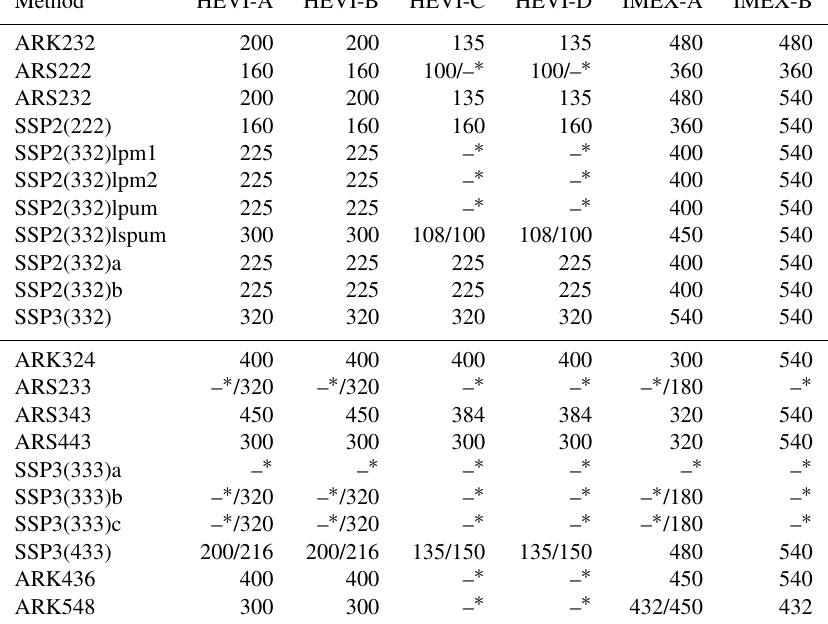
Table 1. Approximate largest stable step size (in seconds) for a 30-day run of the baroclinic wave test. Second-order methods are shown in the top section of the table and higher-order methods in the bottom section. For entries separated by “/”, the left value is the step size for the Rosenbrock-like approach and the right value is the step size for the Newton solver. When a single step size is given, the Rosenbrock-like and Newton solvers were stable at the same step size. As in the gravity wave tests, the choice of a Rosenbrock-like or Newton solver does not generally impact the maximum stable step size, except in the case of IMEX-B which fails to converge. While the methods are able to complete a 30-day run at the step sizes listed below, the solutions produced are not sufficiently accurate in all cases and depend on the solver choice. Table 2 shows the approximate largest step sizes that give acceptable